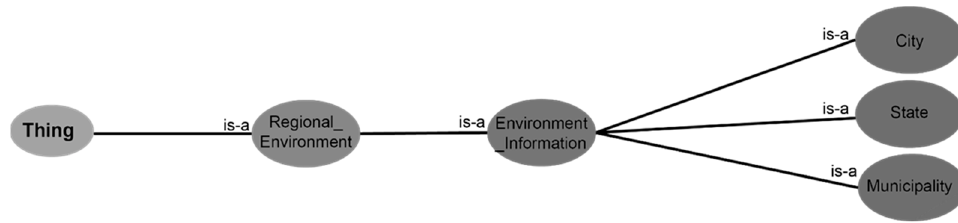
Figure 1. SPO ontology.